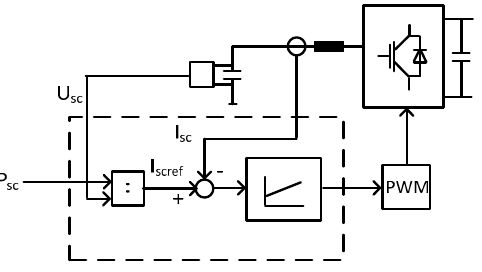
Figure 21. Detailed scheme of the control of the compensation Capacitor.